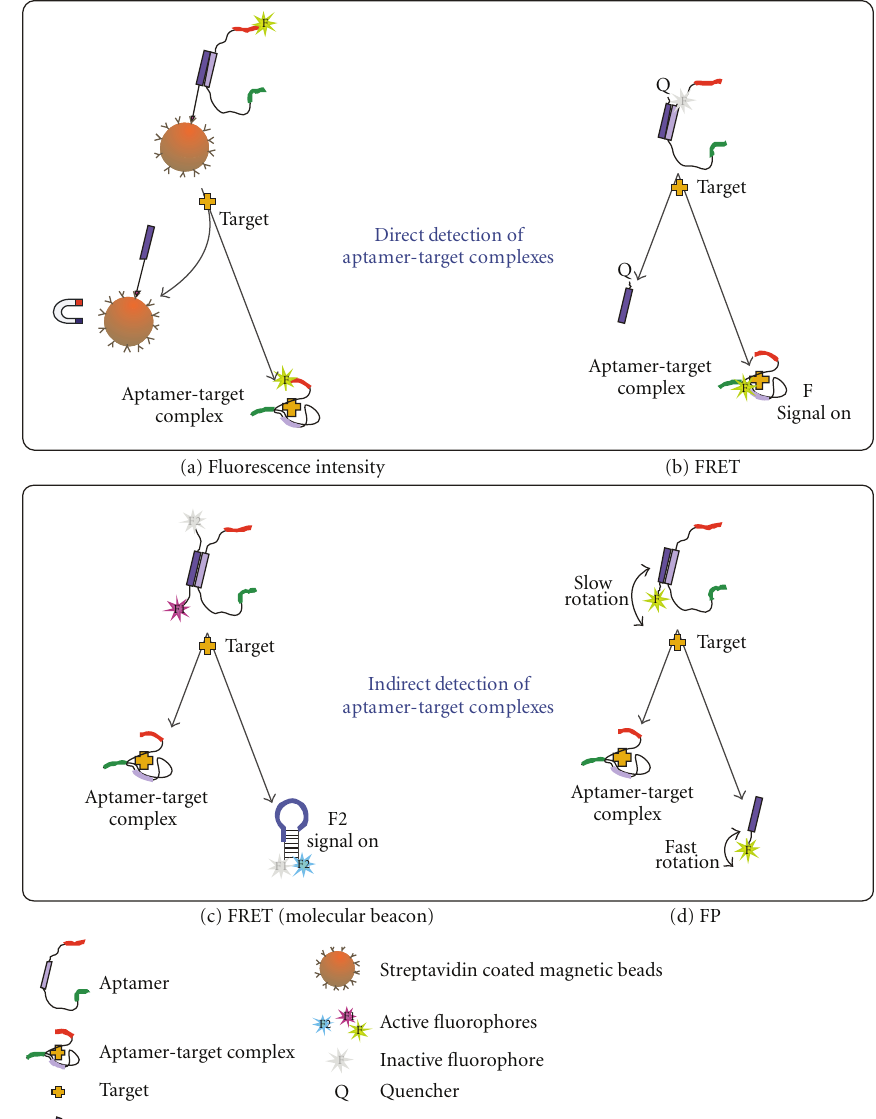
Figure 7: ClustalW [23] comparison of the sequences for kanamycin binding aptamers derived from di ff erent types of SELEX. #3 18 (gr. 7): aptamer developed by Capture-SELEX as described here. Kana18: aptamer developed by Song et al., 2011 [27] using a ffi nity chromatography with kanamycin-immobilized sepharose beads. Fixed regions are marked with green (5 (cid:4) -primer binding regions), blue (3 (cid:4) -primer binding regions), and magenta (docking sequence). Random regions are printed in black. Red: binding region as assumed by Song et al., 2011 [27] and underlined: stem-loop forming sequence as given in [27].